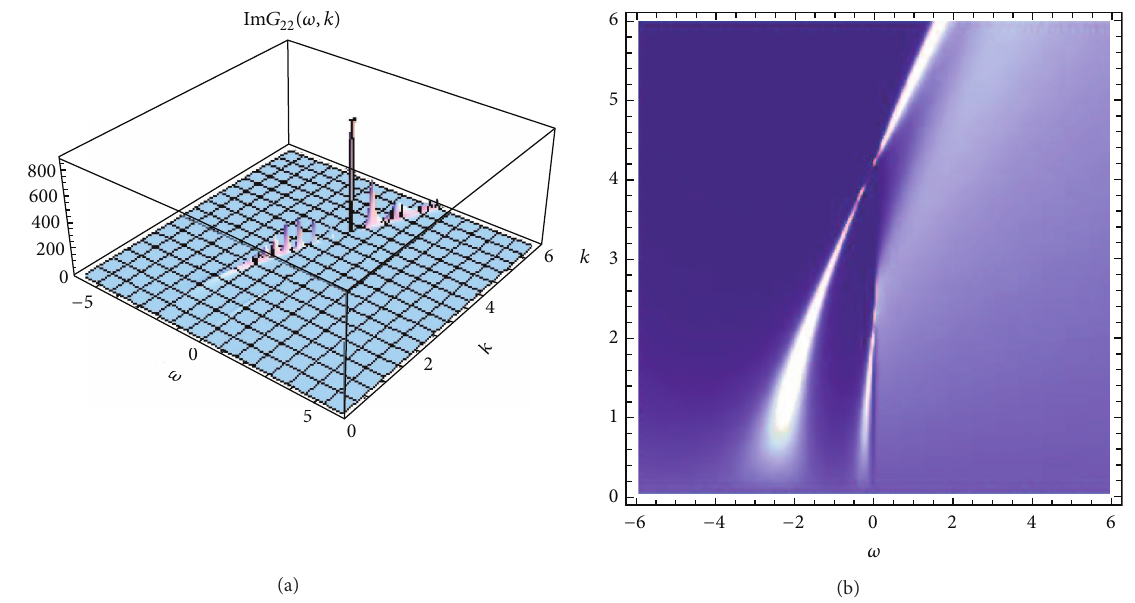
Figure 2: The 3D plot (a) and the density plot (b) of Im 𝐺 22 (𝜔,𝑘) as 𝑎 2 = 0.01 .